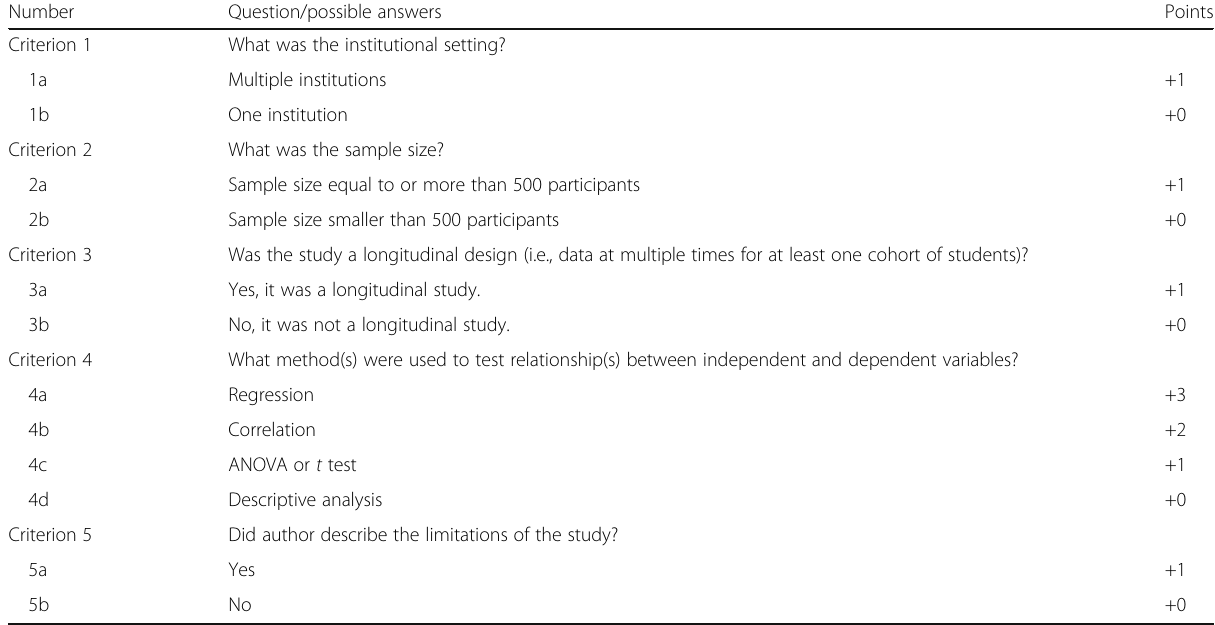
Table 1 Quality appraisal for quantitative